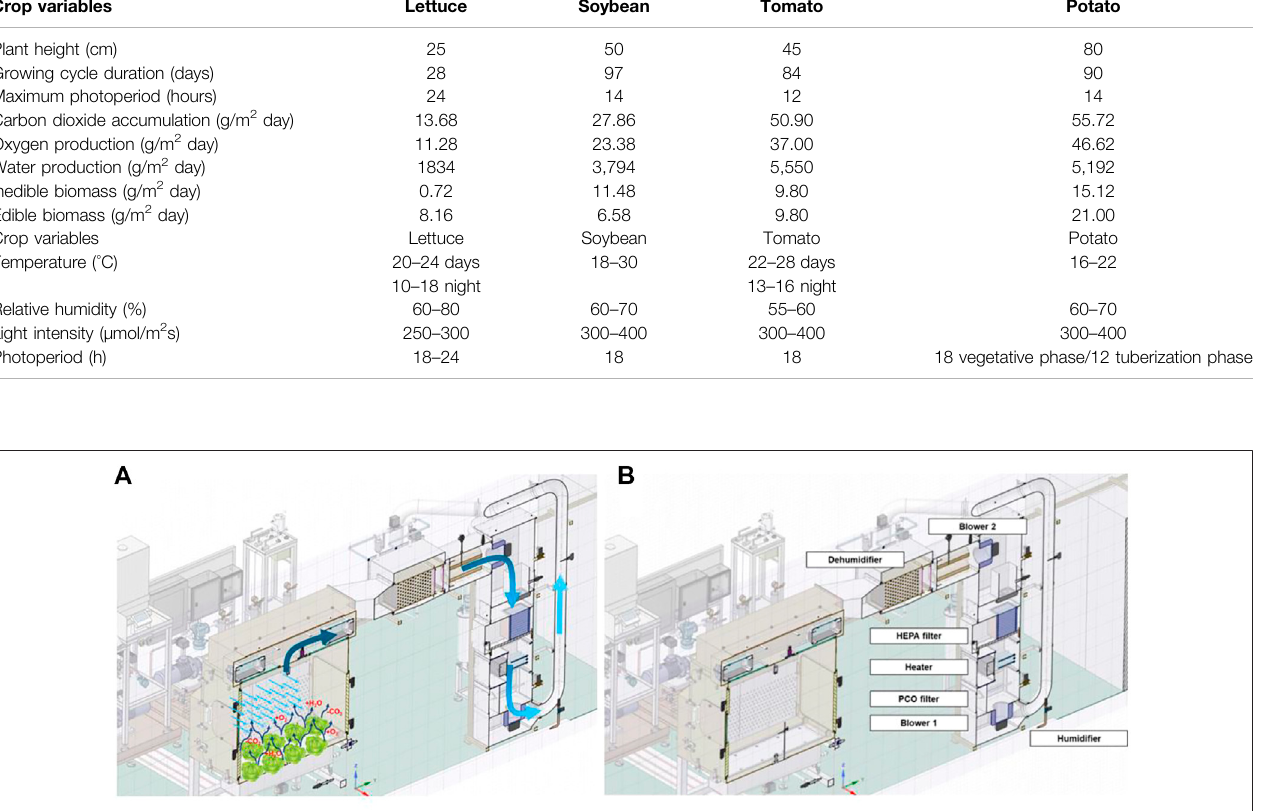
Frontiers in Astronomy and Space Sciences |